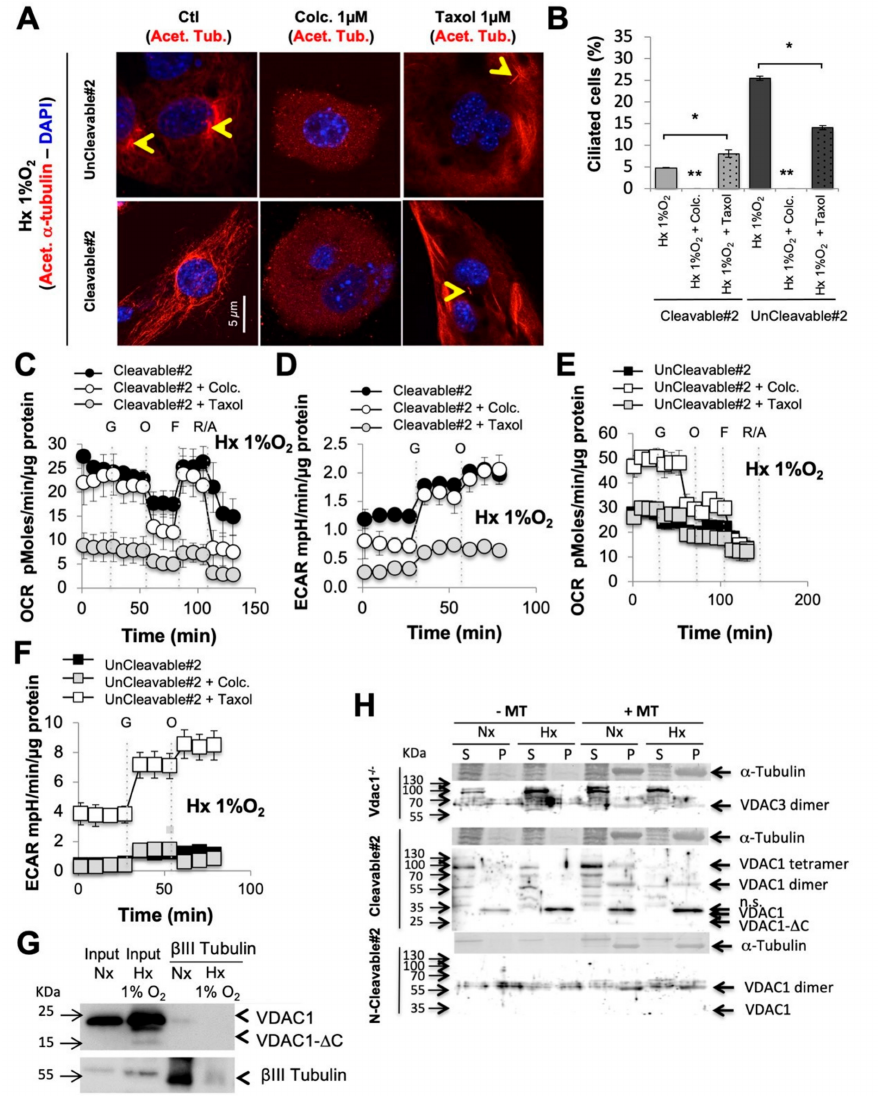
Figure 4. Destabilization or stabilization of the tubulin modified the percentage of primary cilium and metabolism, which was dependent on the cleaved form of VDAC1. ( A ) Immunofluorescence of acetylated α -tubulin (Acet. α -tubulin in red) and DAPI (in blue) in Cleavable#2 and UnCleavable#2 cells in the presence of colchicine (Colc.–1 µ M) or taxol (1 µ M) compared to the control (Ctl) in Hx 1% O 2 for 72 h. ( B ) Quantitative analysis of the e ff ect of the absence or presence of colchicine (Colc.–1 µ M) or taxol (1 µ M) for 72 h on the percentage of ciliation assessed by confocal fluorescence microscopy ( n = 100–300 cells). ( C ) and ( D ) Respiratory control of Cleavable#2 ( C ) and UnCleavable#2 ( D ) in the presence of colchicine (Colc.) or taxol. OCR was measured in real time with the XF24 analyzer in Hx 1% O 2 . Cells were deprived of glucose for 1 h, then glucose (G), oligomycin (O), FCCP (F) and Rotenone + Antimycin A (R / A) were injected at the indicated times. (E) and (F) ECAR in Hx 1% O2 of Cleavable#2 ( E ) and UnCleavable#2 ( F ) in the presence of colchicine (Colc.) or taxol was evaluated with the XF24 analyzer. Cells were deprived of glucose for 1 h, then glucose (G) and oligomycin (O) were injected at the indicated times. ( G ) β III Tubulin co-immunoprecipitating with VDAC1 in Wt cells in normoxia and hypoxia. ( H ) Pelleting assay for microtubule-associated proteins. Vdac1 − / − , Cleavable#2 and UnCleavable#2 cells were incubated in the absence ( − MT) or presence of taxol-stabilized microtubules ( + MT). The amounts of VDAC1 and tubulin in the supernatant (S) and pellet (P) were analyzed by SDS-PAGE and immunoblotting. A * p < 0.05 and ** p < 0.005 show significant di ff erences. The uncropped Western Blot figures in Figure